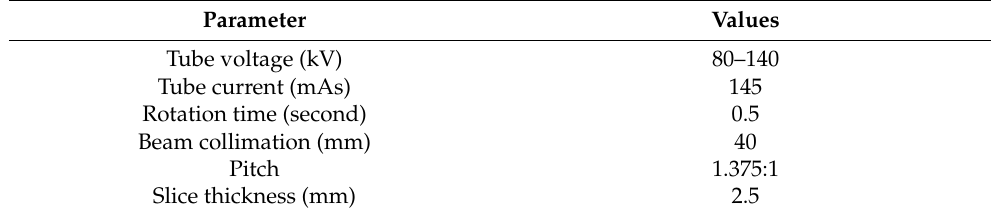
Table 1. Protocol of the low-dose dual-energy CT.